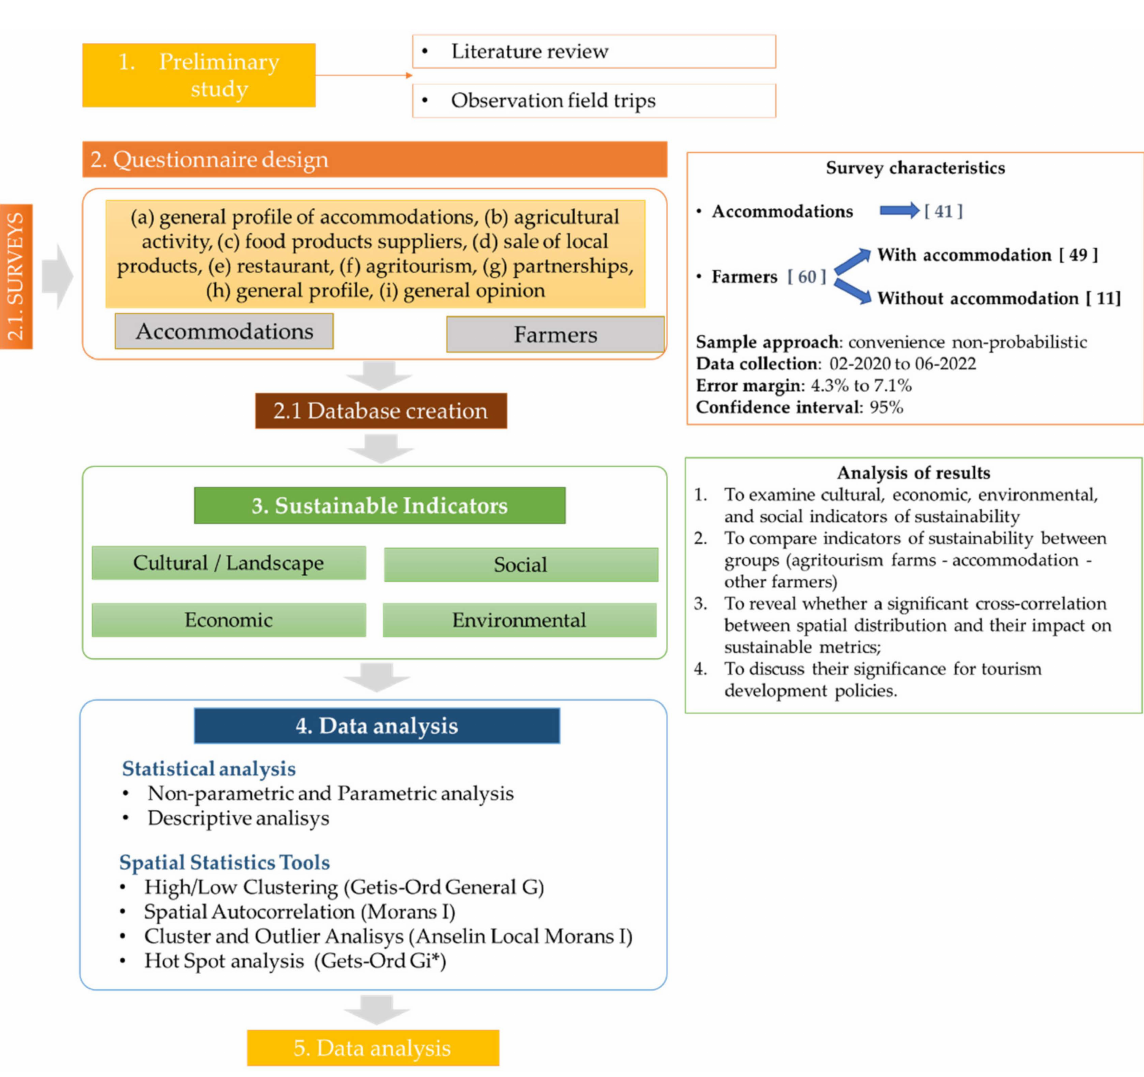
Figure 1. Methodological